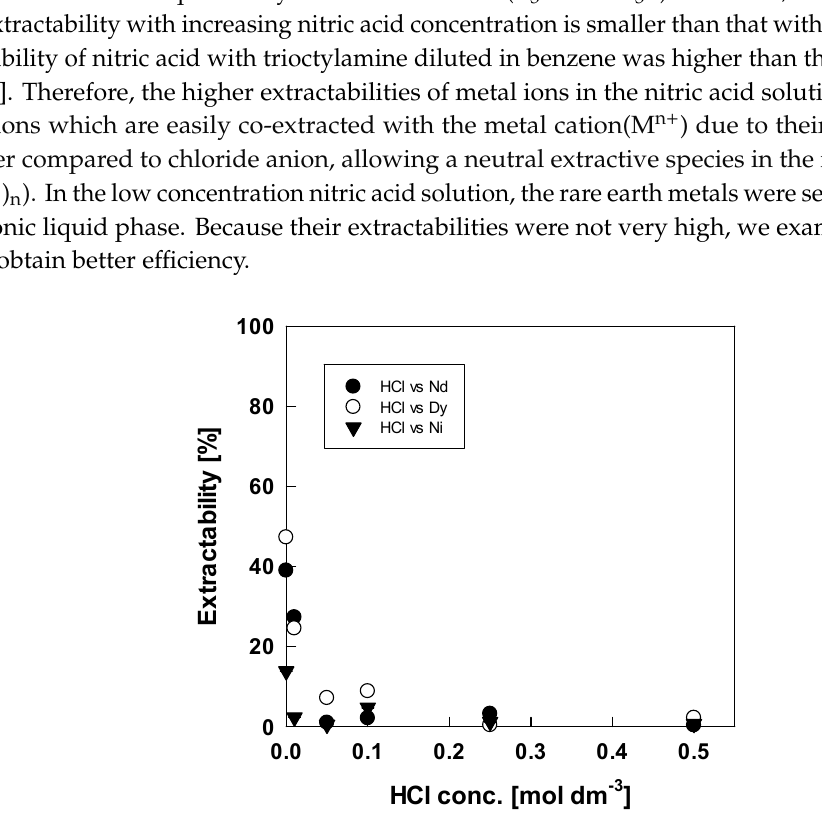
Figure 1. E ff ect of HCl concentration on metal extractability. Figure 1. Effect of HCl concentration on metal extractability.